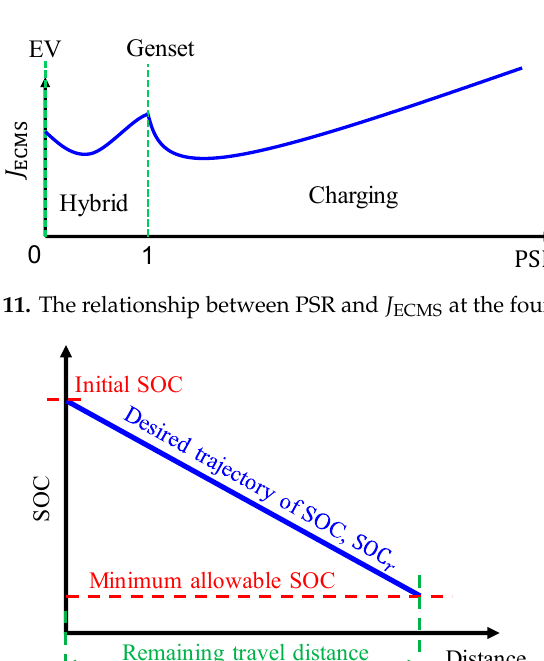
Figure 12. The desired trajectory of SOC for discharging the battery.